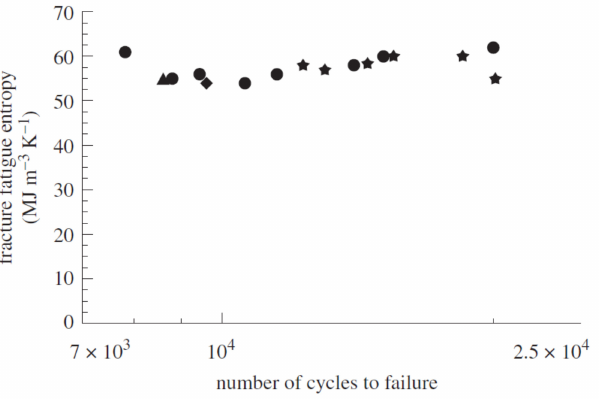
Figure 2. Experimental fracture fatigue entropy versus the number of cycles to failure for bending and torsional fatigue tests of SS 304 for different loads and frequencies [86].This picture is ©2009 The Royal